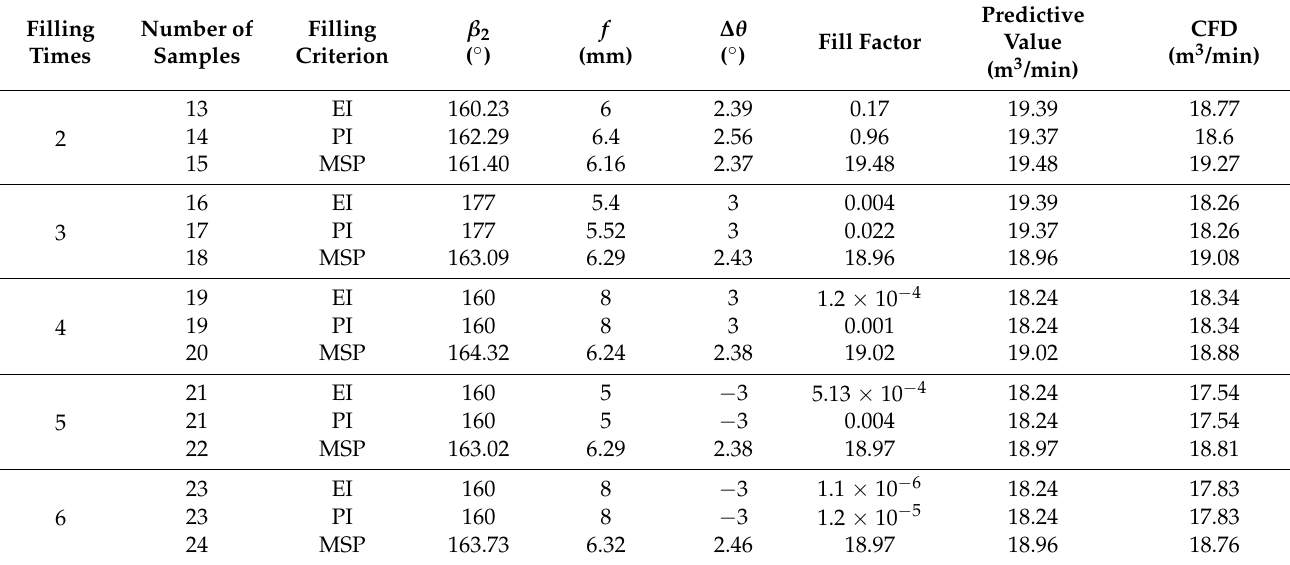
Table 6. Filling process in the improvement